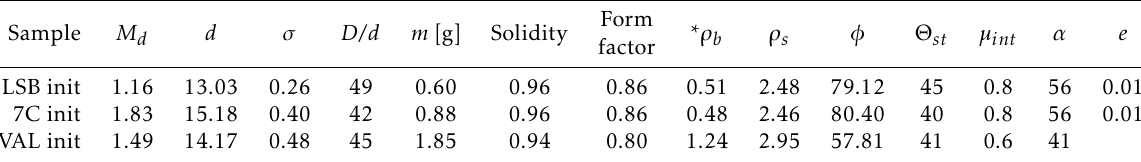
Figure 2: Photographs of 100 representative clasts of the starting material for [A] Laacher See, [B] Sete Cidades and [C] Valentano. Black/white background allowed for better contrast as images were processed to obtain size and shape data. The bottom-left scale bar (white or black line) is 10 cm. Table 3 – Average initial clast properties of the starting materials. Clast dimensions and shape factors were calculated from image analysis, while bulk density and porosity was calculated from calliper measurements